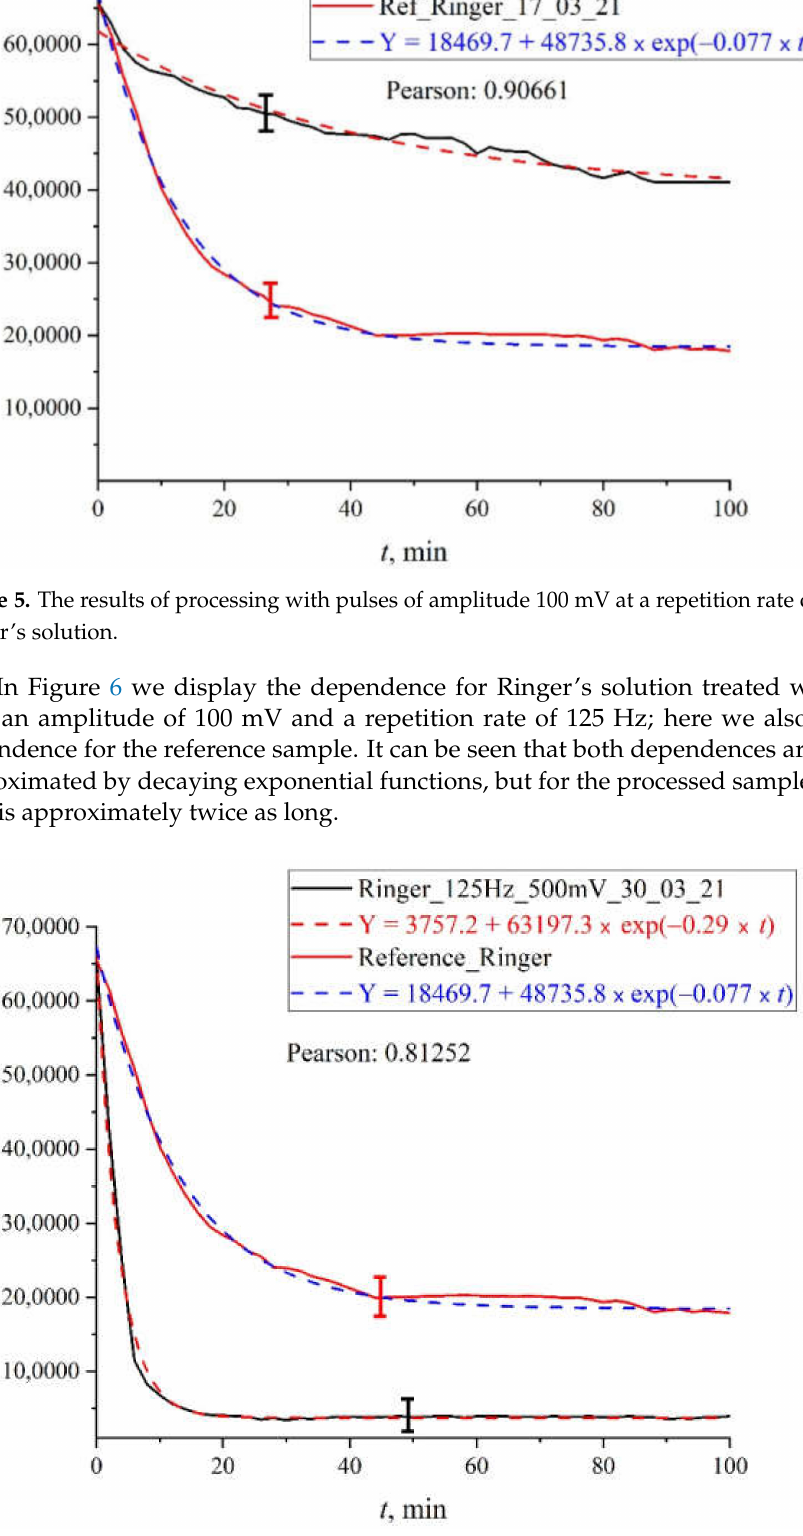
Figure 6. The results of processing with pulses of amplitude 125 mV at a repetition rate of 500 Hz: for Ringer’s